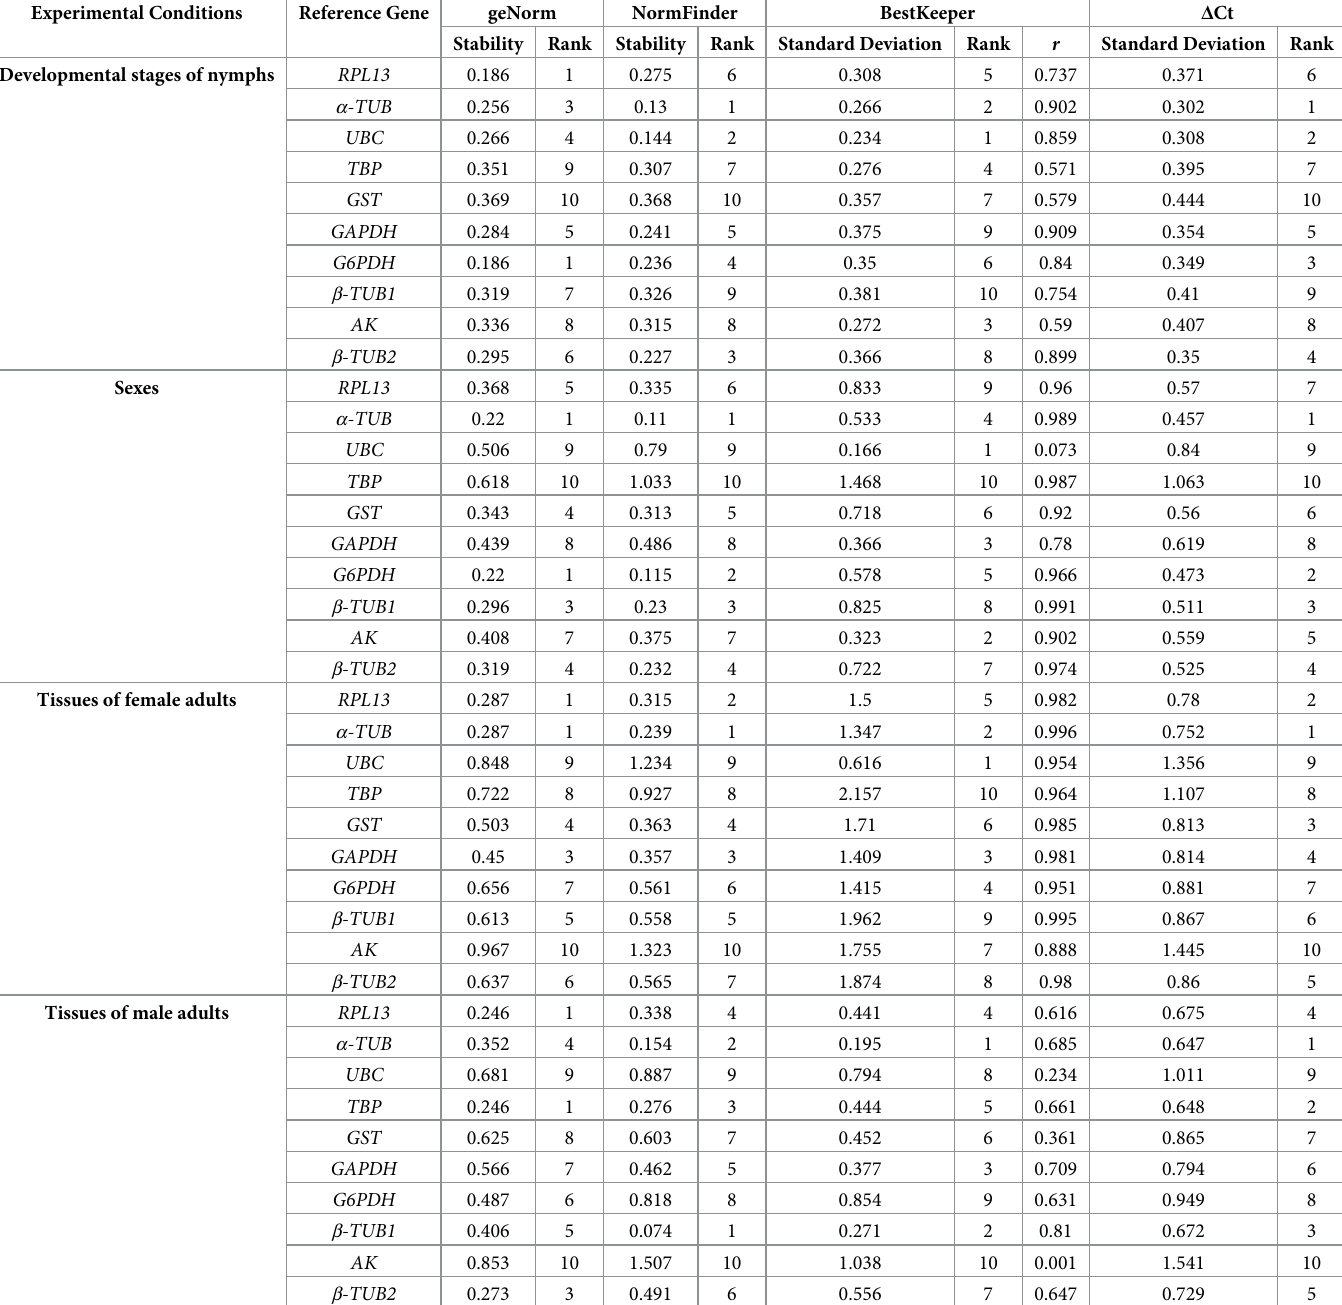
Table 4. Ranking of reference genes expression under different experimental treatments.